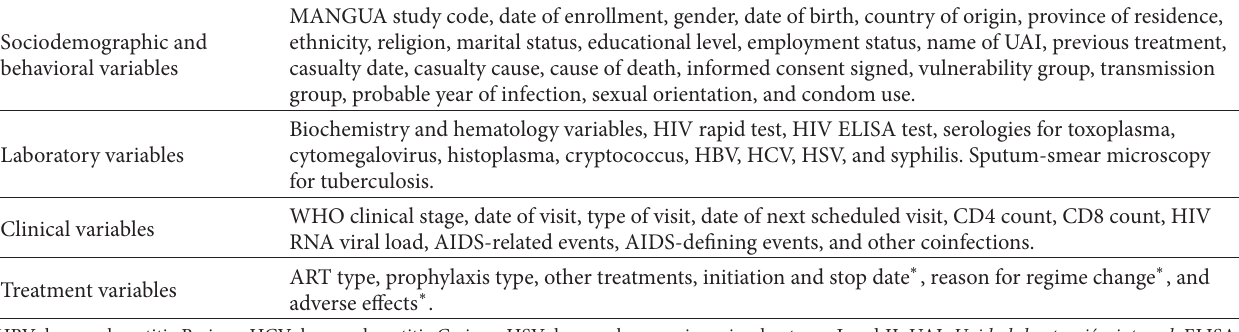
Table 1: Standardized variables collected in